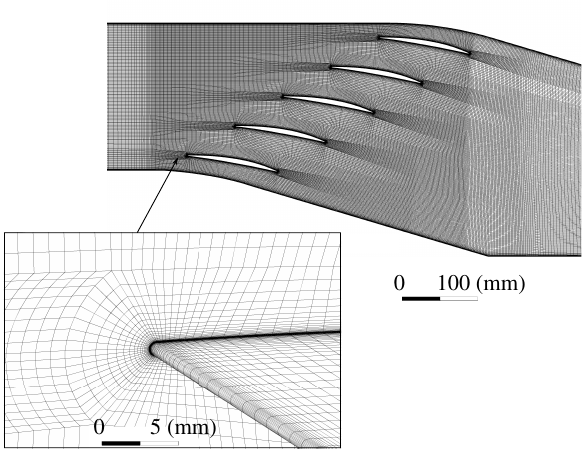
Fig. 4. Computational grid around the cascade and the detail of the blade – end wall transition close to a blade leading